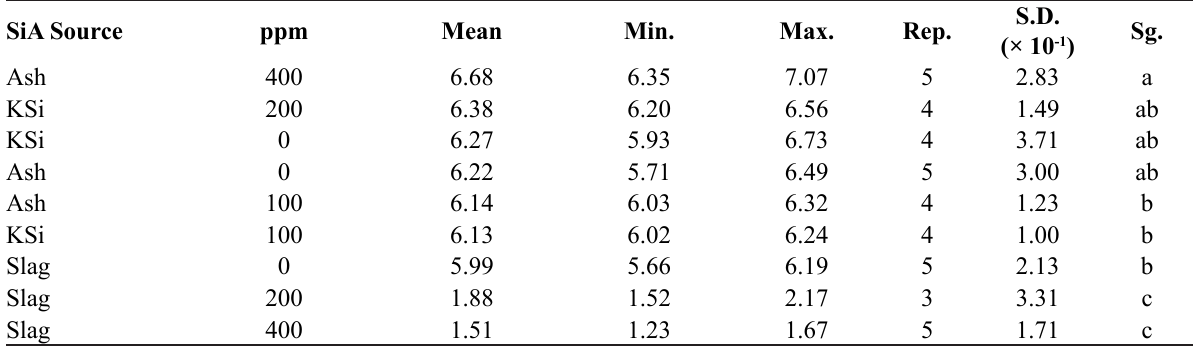
Table 5. Statistical summary of root volume (cm 3 ) data, transformed with . Significance levels were obtained with Tukey test, α =